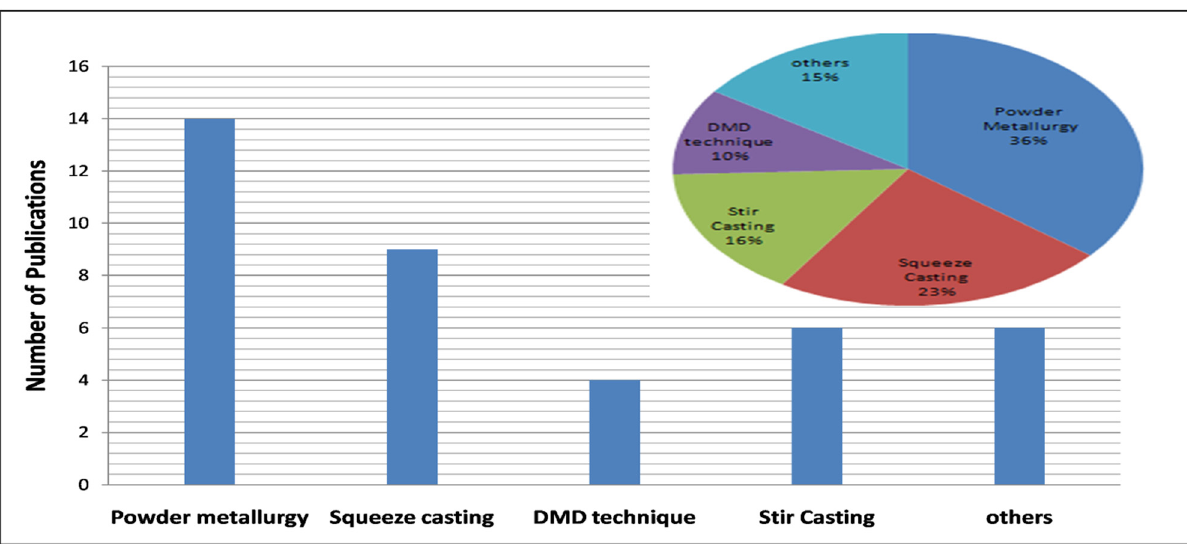
Figure 4: Percentage contribution of di ff erent fabrication techniques for magnesium - based MMCs reviewed in this